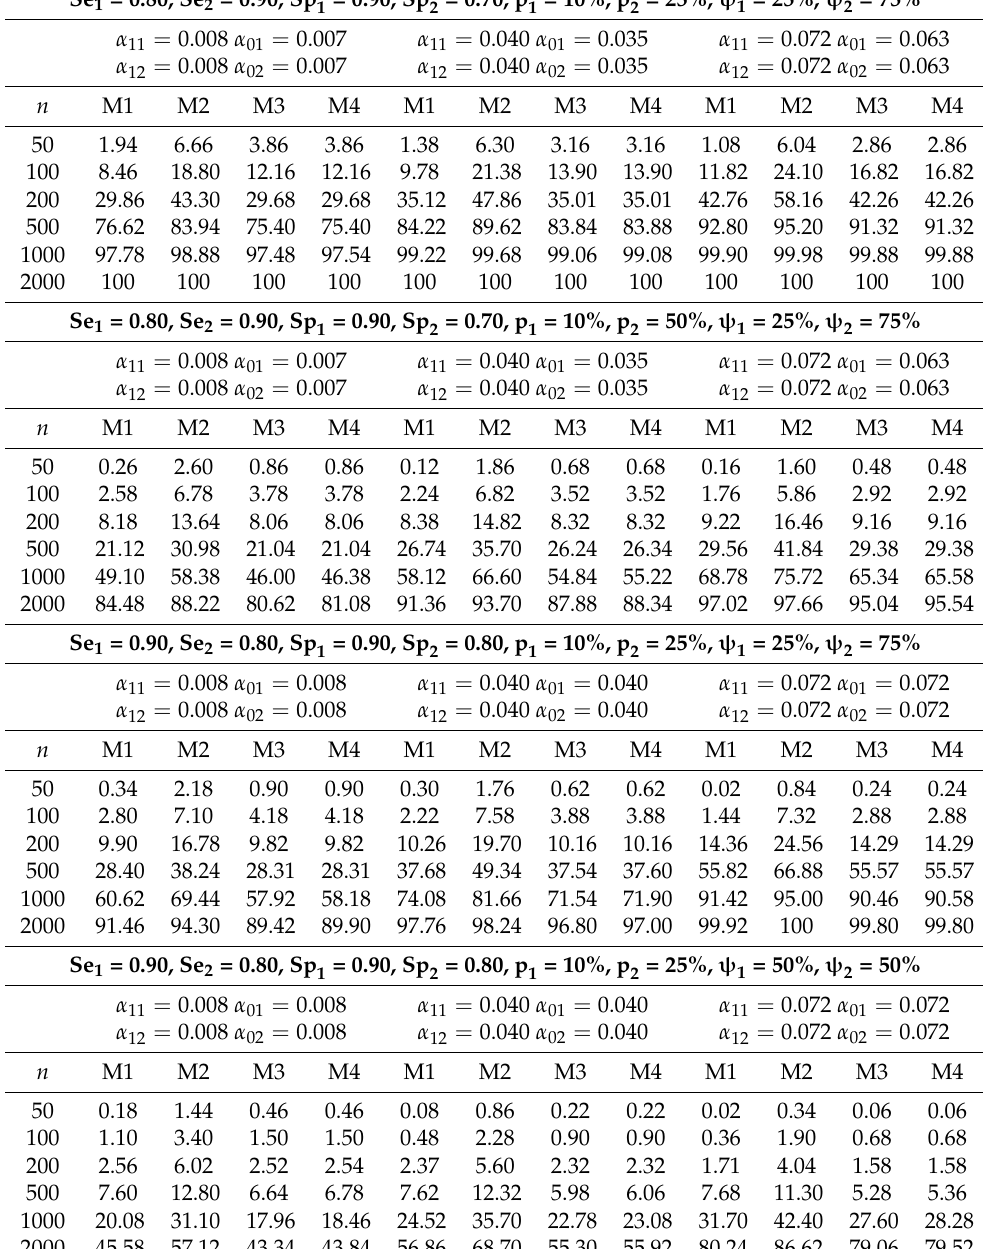
Powers (in %) of different methods to simultaneously compare the sensitivities = { 0.80,0.90 } ) and specificities ( Sp ( Se h binary